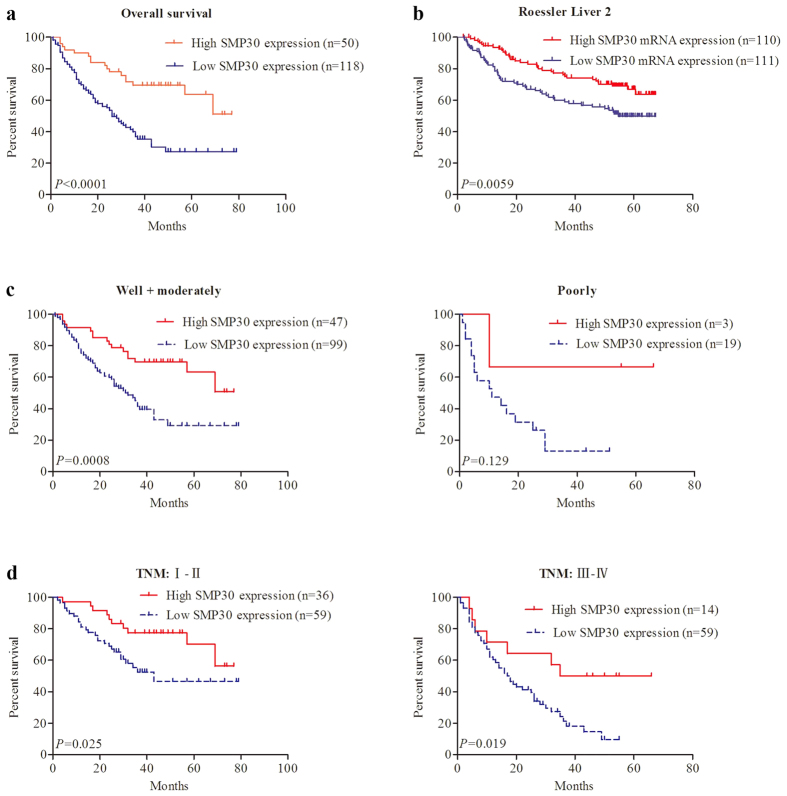
Showing SMP30 expression associated with OS rate in HCC patients.(a) Kaplan-Meier curves for OS in relation to SMP30 staining for 168 HCC patients. (b) Kaplan-Meier survival curve analysis of HCC patients with SMP30 mRNA higher-than-median or lower-than-median using Roessler Liver 2 dataset from Oncomine database. (c) Kaplan-Meier curves for OS in relation to SMP30 expression in well and moderately differentiated cohort and in poor differentiated cohort. (d) Kaplan-Meier curves for OS in relation to SMP30 expression in TNM stage (I–II) cohort and in TNM stage (III–IV) cohort. P values have been obtained using log-rank method.